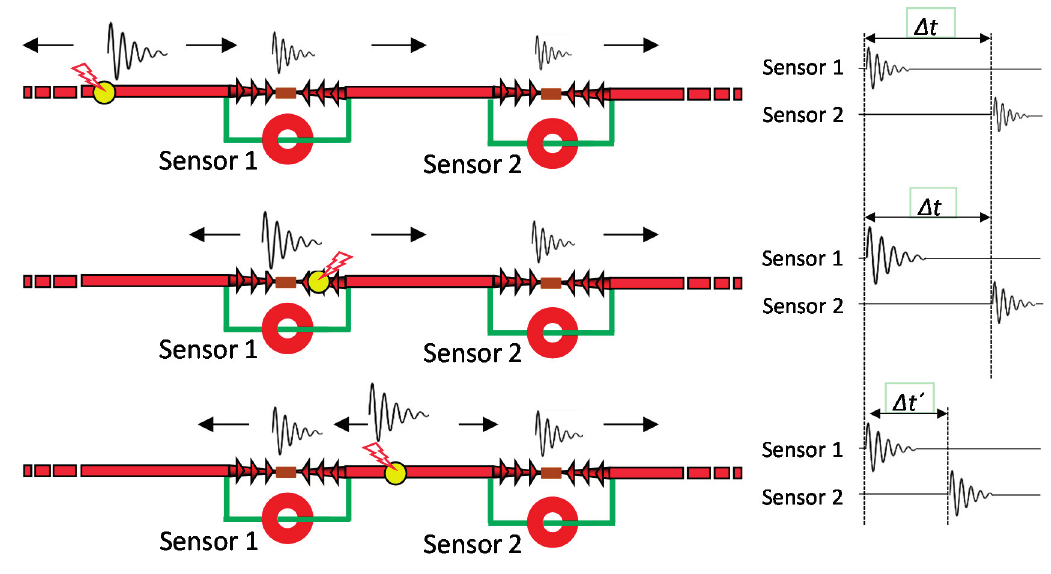
Figure 25. ( a ) Defect before the section of cable between sensors; ( b ) Defect located in the same emplacement as one of the sensors; ( c ) Defect inside the section of cable between sensors.